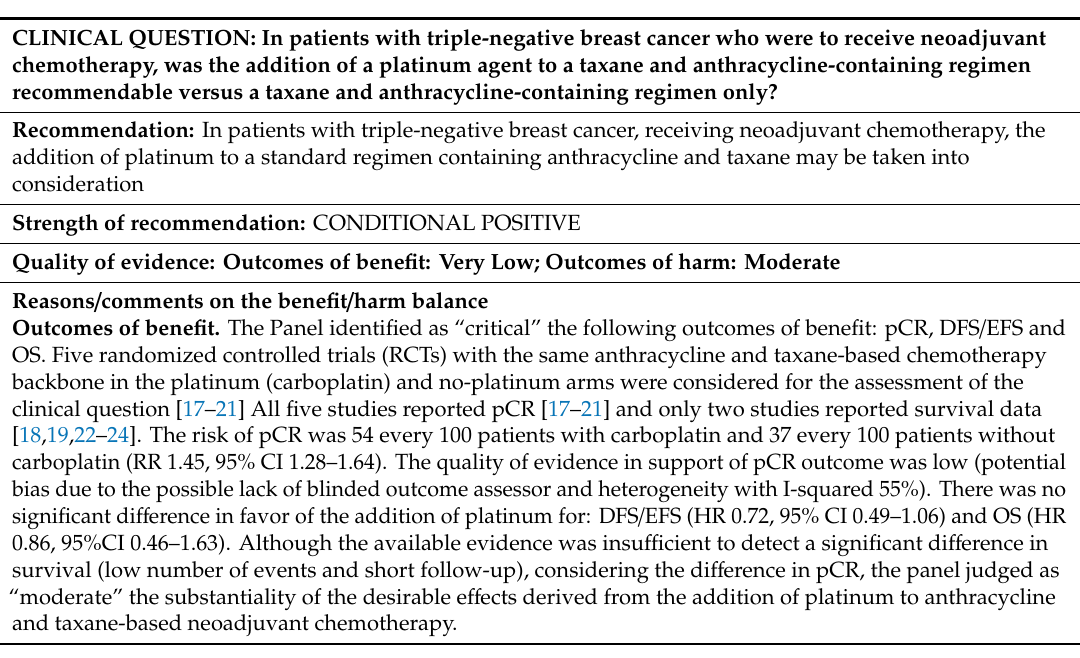
Table 3. Final recommendation and summary of GRADE